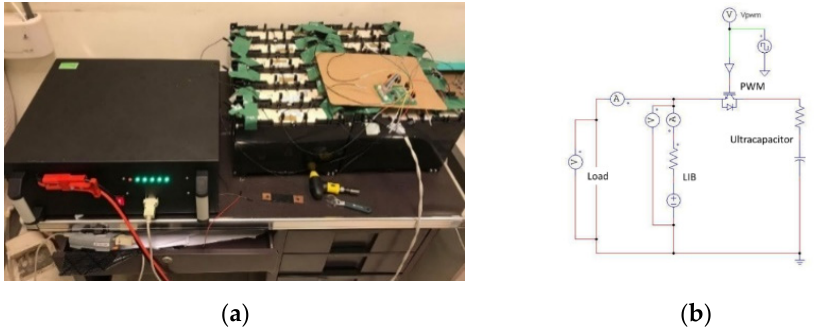
Figure 4. ( a ) Two battery packs in test bench (52 V and 50.4 V); ( b ) circuit of BMS with pulse-width modulation (PWM) control.